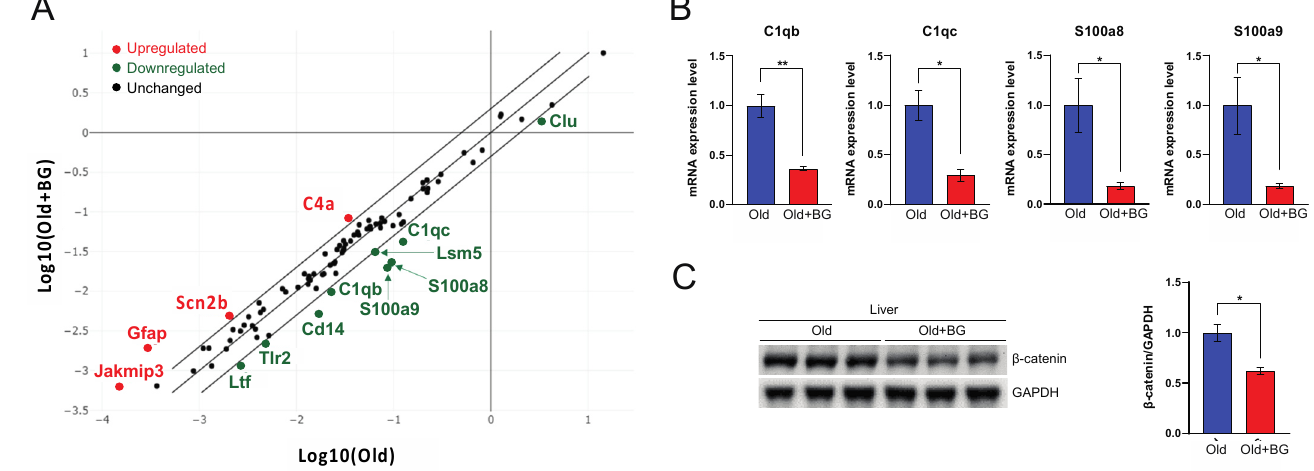
Figure 3. Scatter plot ( A ) of aging-associated genes between Old ( x -axis) and Old+BG ( y -axis) group, an mRNA expression level ( B ) of C1qb , C1qc , S100a8 , S100a9, and western blot ( C ) of β -catenin and its quantification. In Figure 3A, the red, green, and black dots indicate upregulated, downregulated, and unchanged genes, respectively. * p ≤ 0.05 and ** p ≤ 0.01.